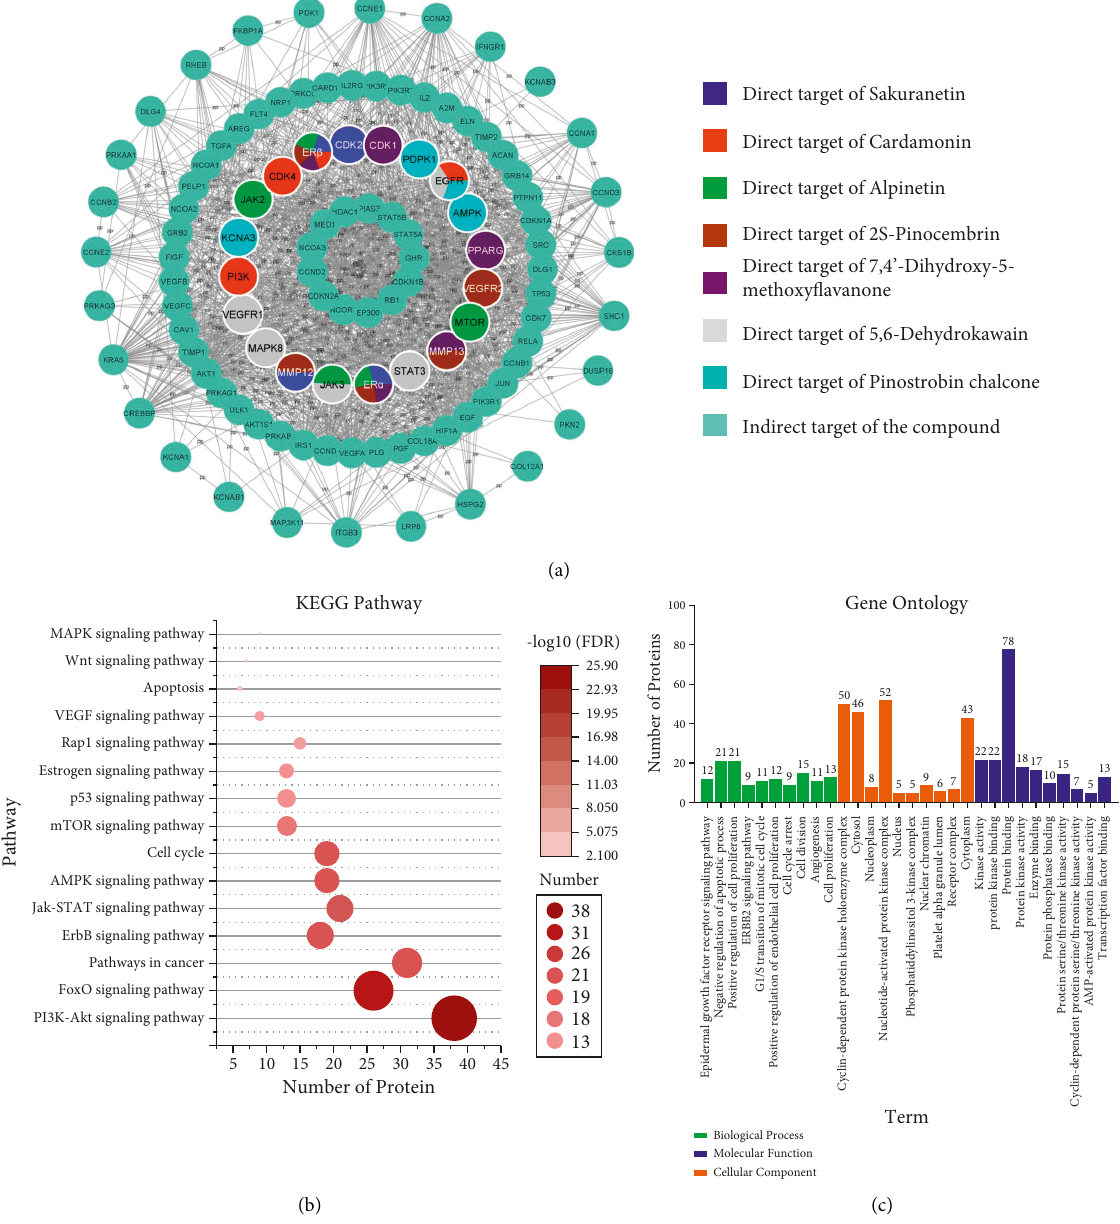
Figure 2: Target proteins of the seven chosen compounds in B. rotunda . (a) Direct and indirect targets of the compounds. (b) KEGG pathway related to target proteins. (c) GO terms related to the target